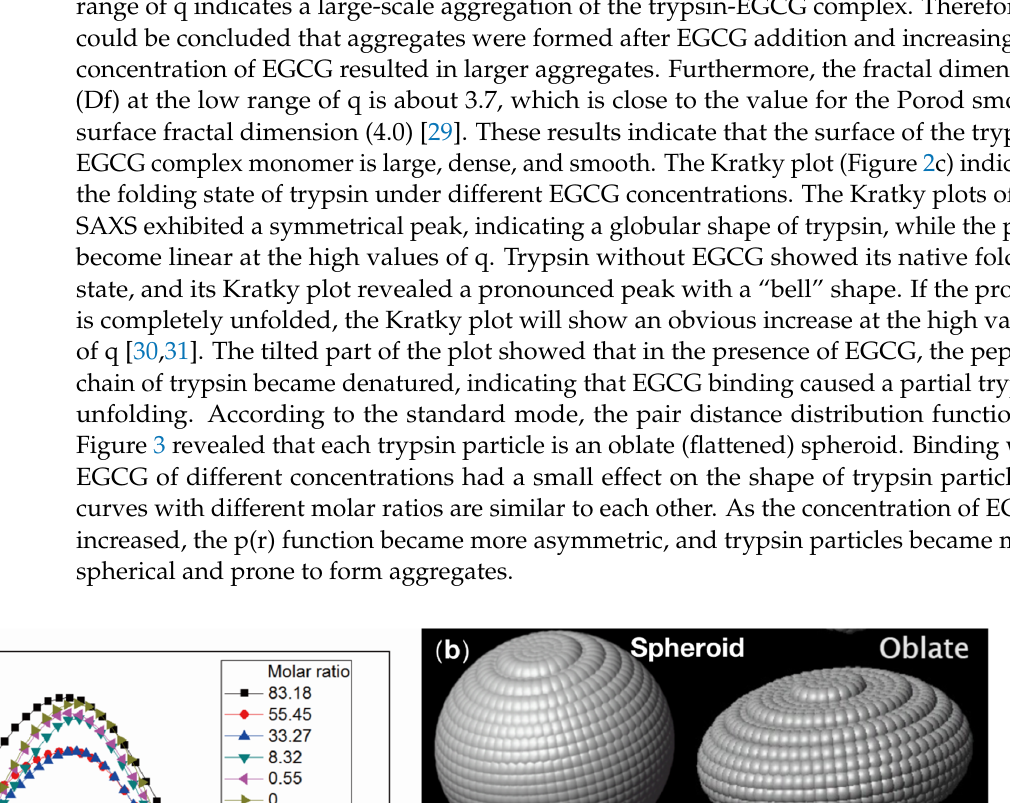
Figure 2. ( a ) The intensity profiles from SAXS of trypsin in 1 mg/mL solution and the PDB photo of trypsin. The inset shows the pair distance distribution function. ( b ) The scattering intensity profiles of trypsin-EGCG complex with different concentrations of EGCG. ( c ) The Kratky plot of the trypsin-EGCG complex as a function of the molar ratios of EGCG/tryp- sin (the concentration of trypsin was fixed at 1 mg/mL).